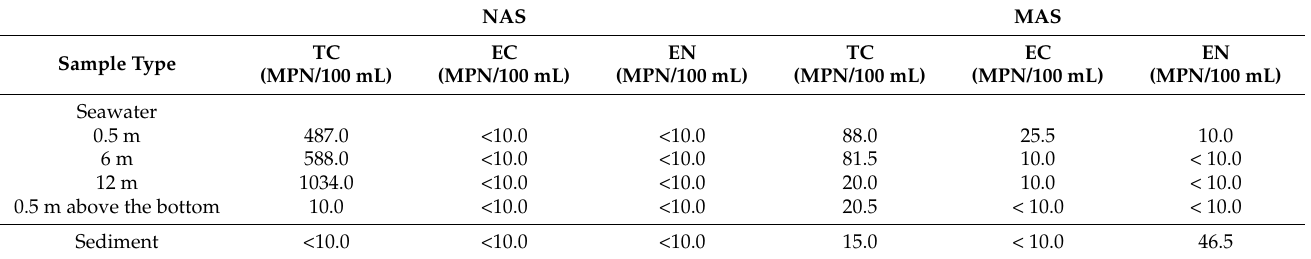
Table 2. Microbiological analysis of seawater and sediment from the NAS and MAS farms. NAS